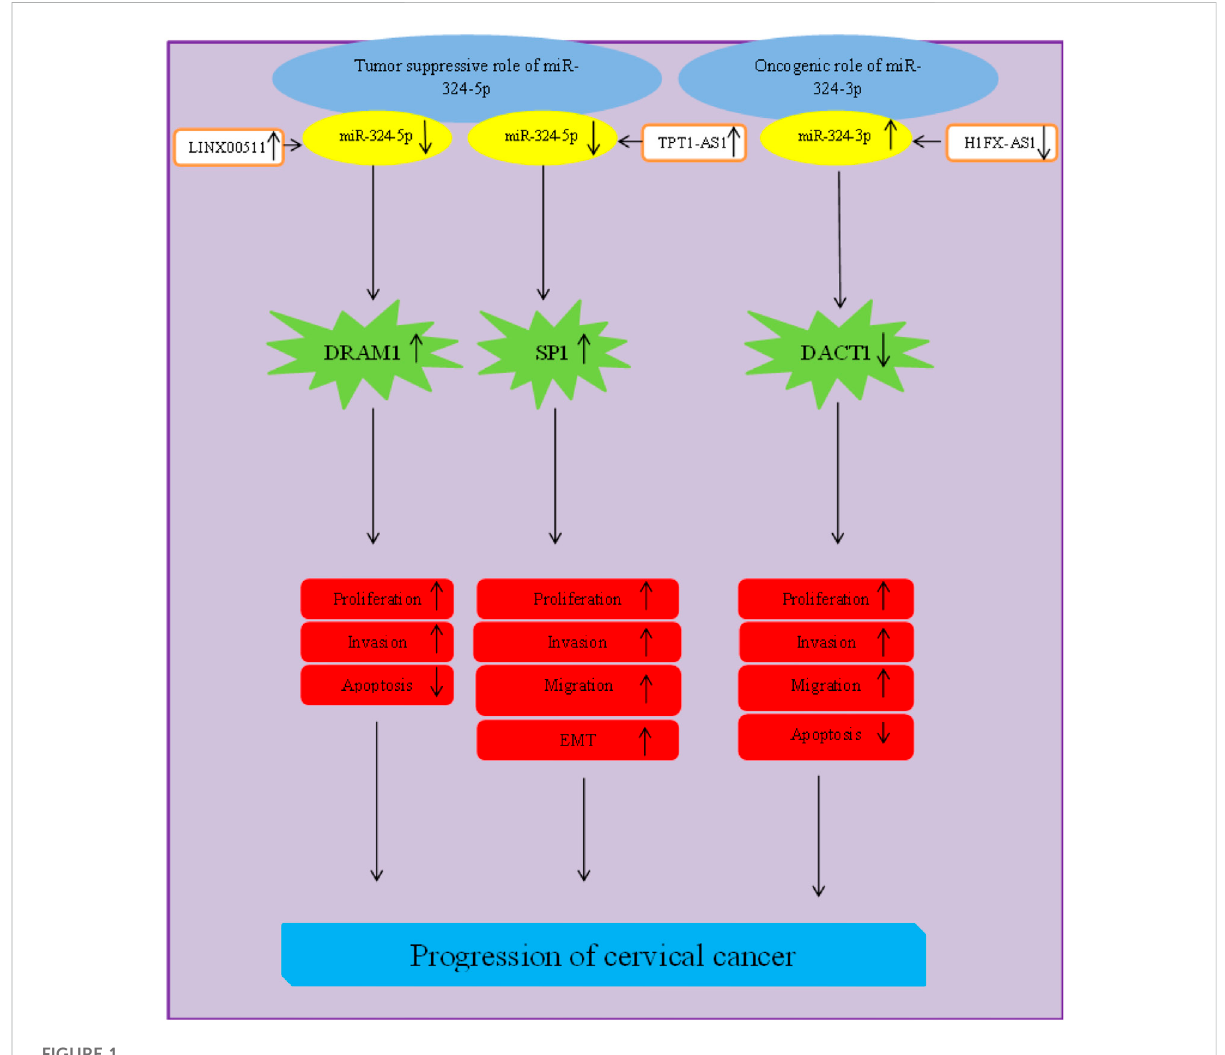
FIGURE 1 Role of miR-324 in progression of cervical